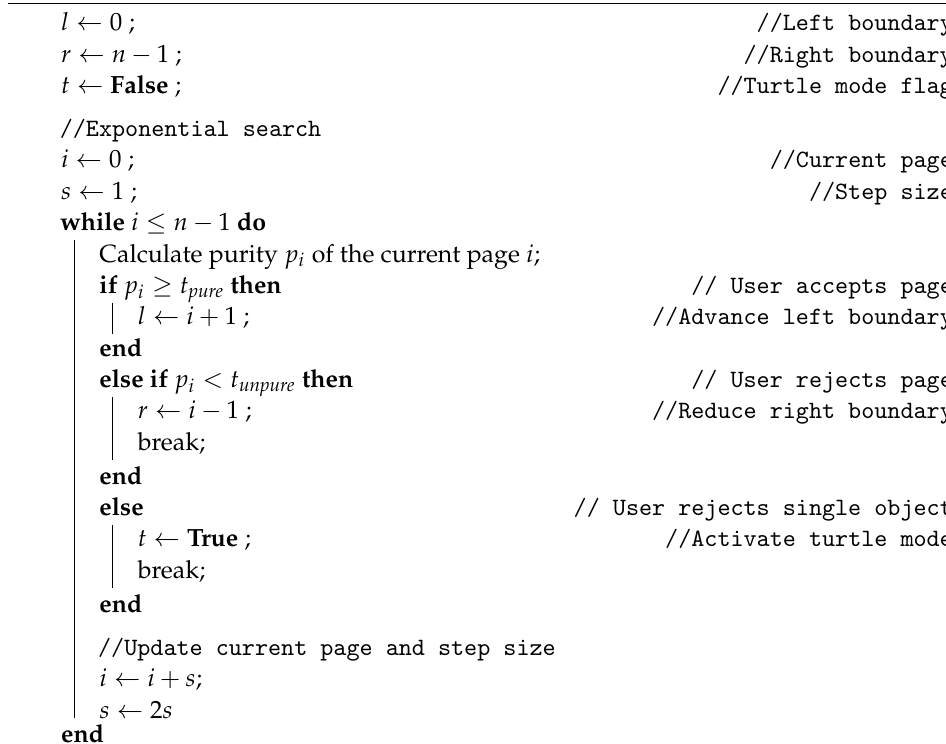
Algorithm A1: Growing: Initialization and Exponential